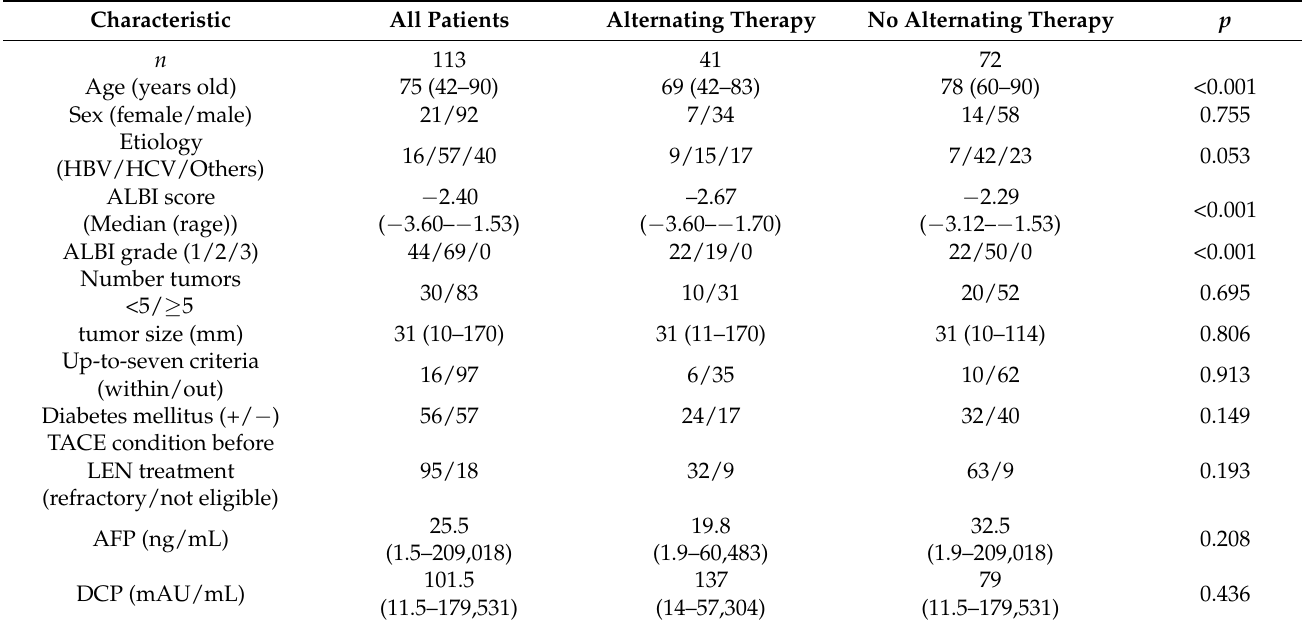
Table 1. Patient characteristics.